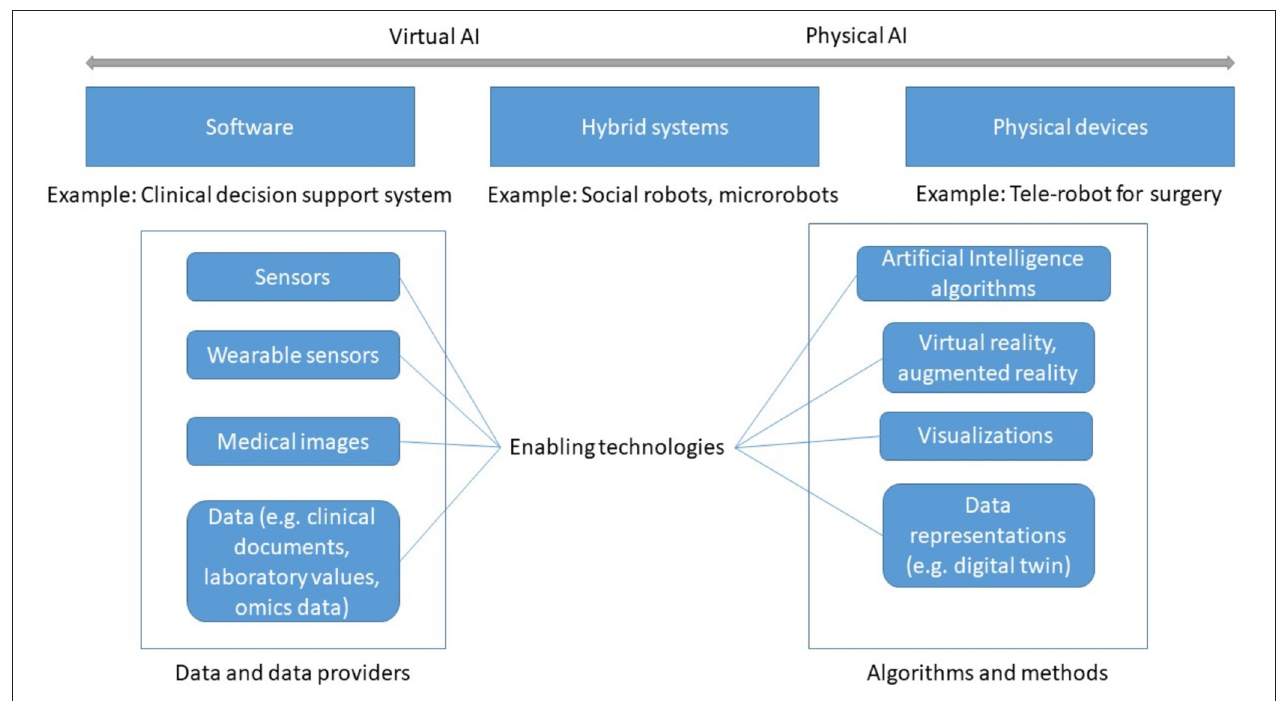
FIGURE 2 | Types of AI-based systems and enabling technologies.